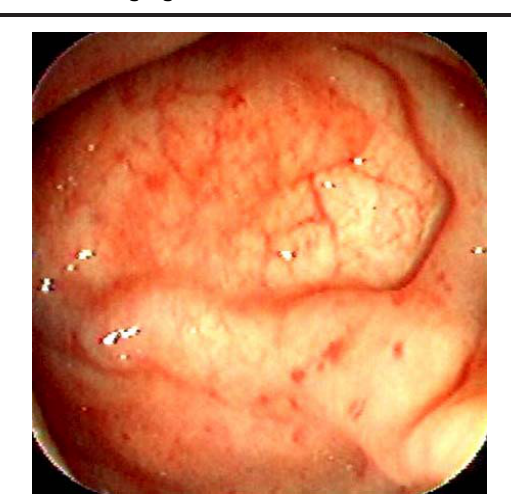
FIGURE 2 - Colonoscopic view of telanfiectasic lesions of the colon showing tortuosity and engorgement of small vessels (GII).